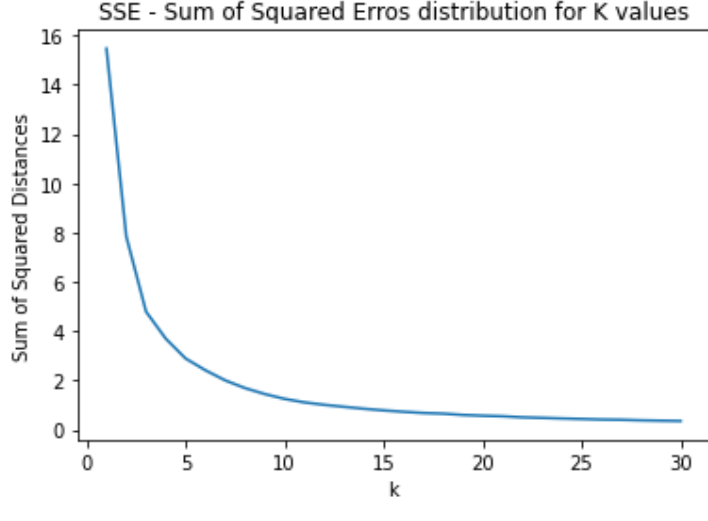
Figure 13. SSE Plot for Parque das Nações